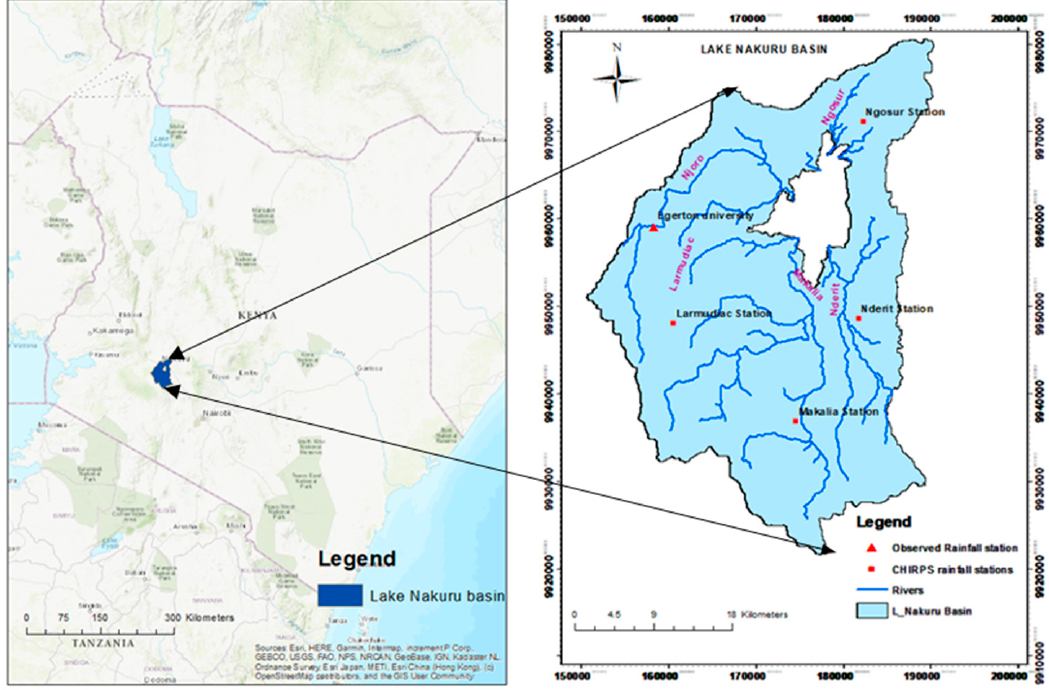
Figure 1. Location of Lake Nakuru.